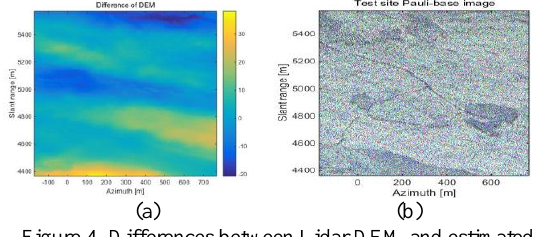
Figure 4. Differences between Lidar DEM and estimated DEM(a) and Test site Pauli-base image